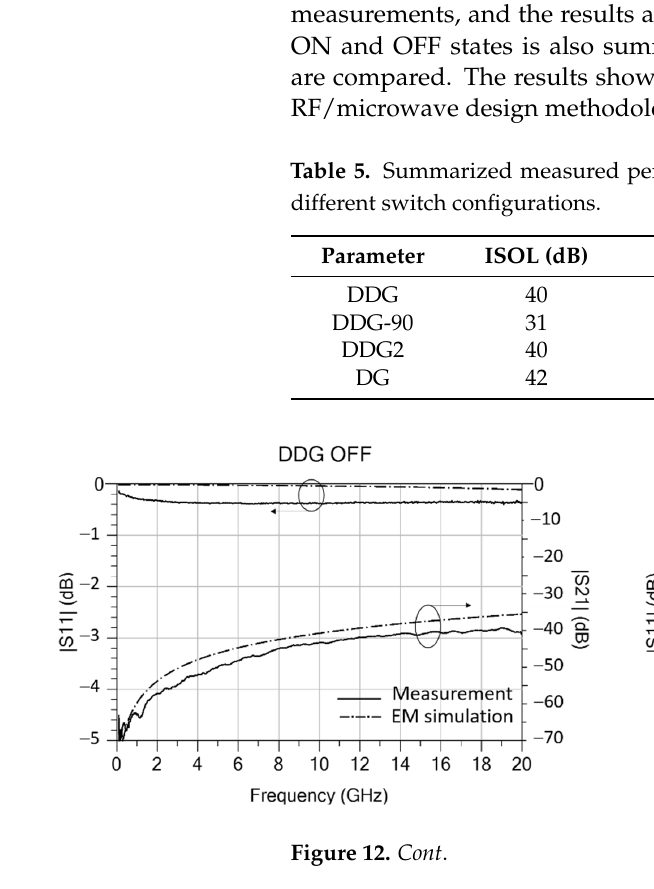
Since windowed ( ‒ W) and not ‐ windowed ( ‒ NW) configurations exhibit very similar RF performance they are not separately plotted. As predicted from simulations in Section 3.3,